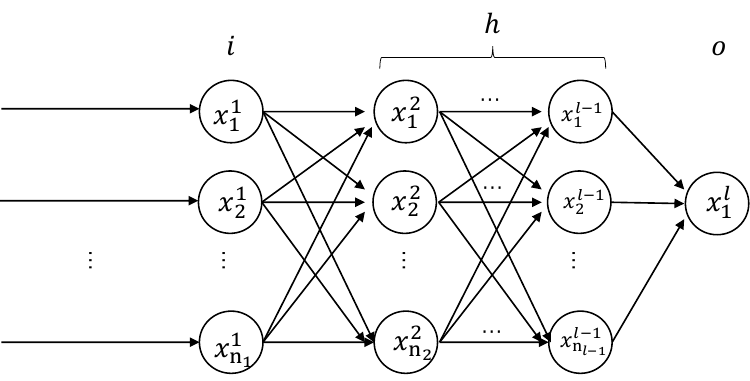
Figure 2 . The architecture of an ANN used in this paper. ‘i’, ‘h’ and ‘o’ stand for input layer, hidden layer and output layer, respectively. l is the number of layers and n i is the number of neurons in the i -th